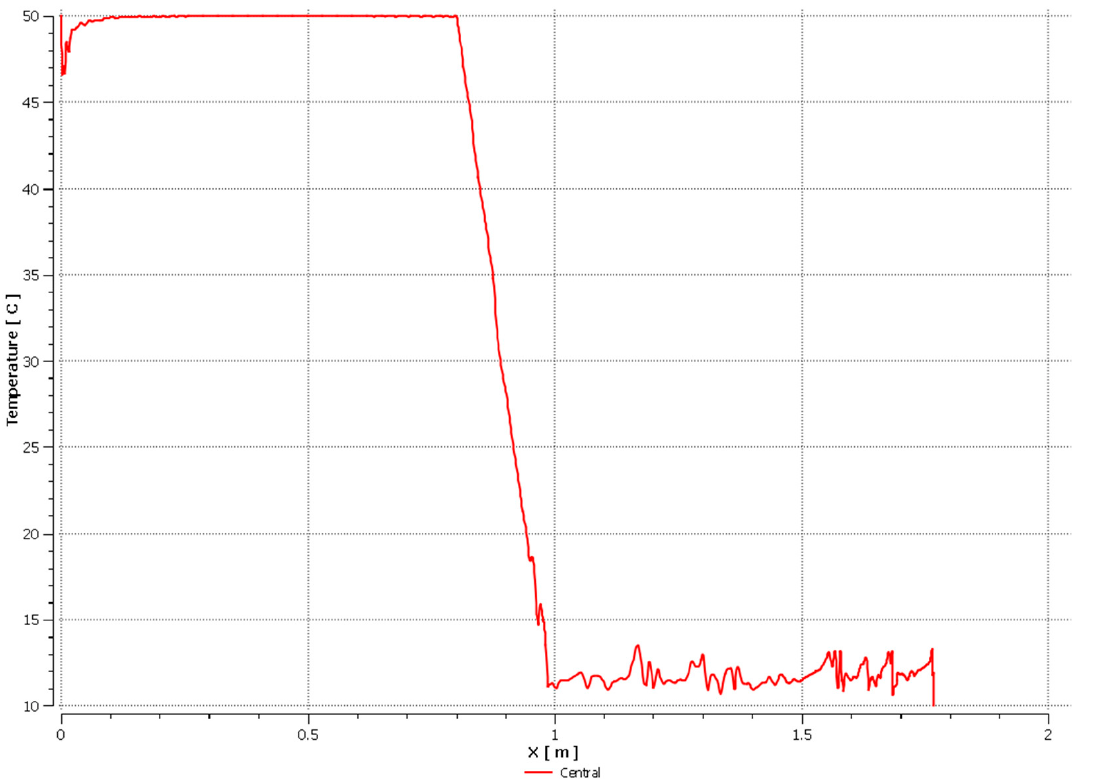
Figure 21. Temperature distribution along the height of the heat pipe’s wall.